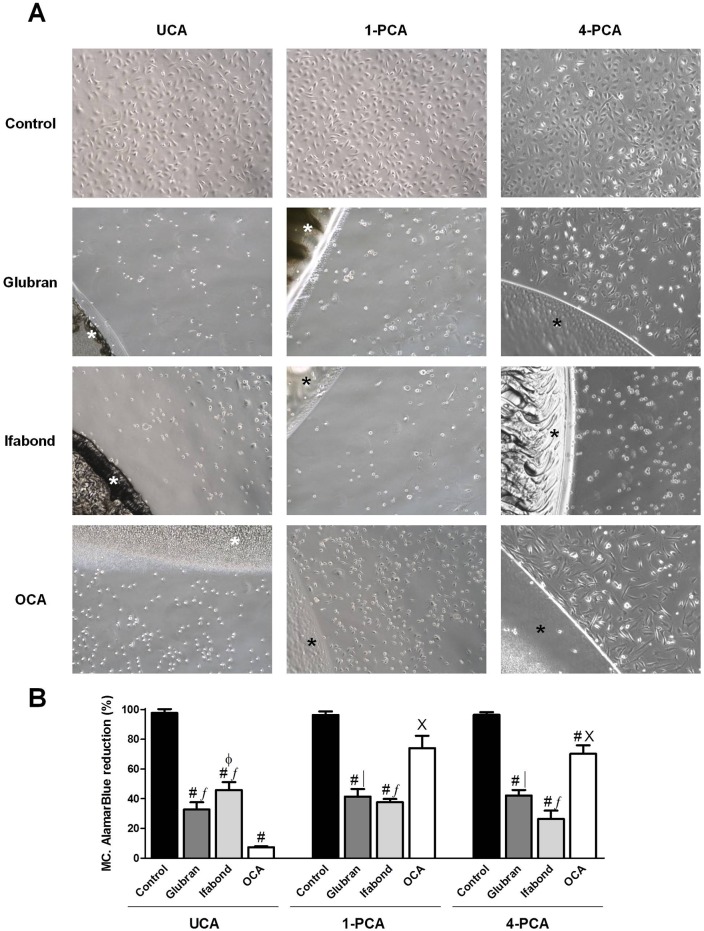
Mesothelial cell viability.(A) Macroscopic visual assessment. Images of the cultured mesothelial cells after 24 hours of exposure to unpolymerized CAs (UCA) and polymerized for 1 and 4 days (1-PCA and 4-PCA) different CAs (Glubran, Ifabond, and OCA) vs. non-exposed cells (control) (100x). (*: Tissue Adhesive). (B) Mean percentage of the Alamar Blue reduction from mesothelial cells treated with the different CAs. The results are expressed as the mean ± SEM for 3 independent assays performed in quadruplicate. Comparisons between groups: #: vs. control (***; p<0.001); ∫: vs. OCA (***; p<0.001); │: vs. OCA (**; p<0.01). Comparisons between times: X: vs. UCA (***; p<0.001); Φ: vs. 4-PCA (*; p<0.05).